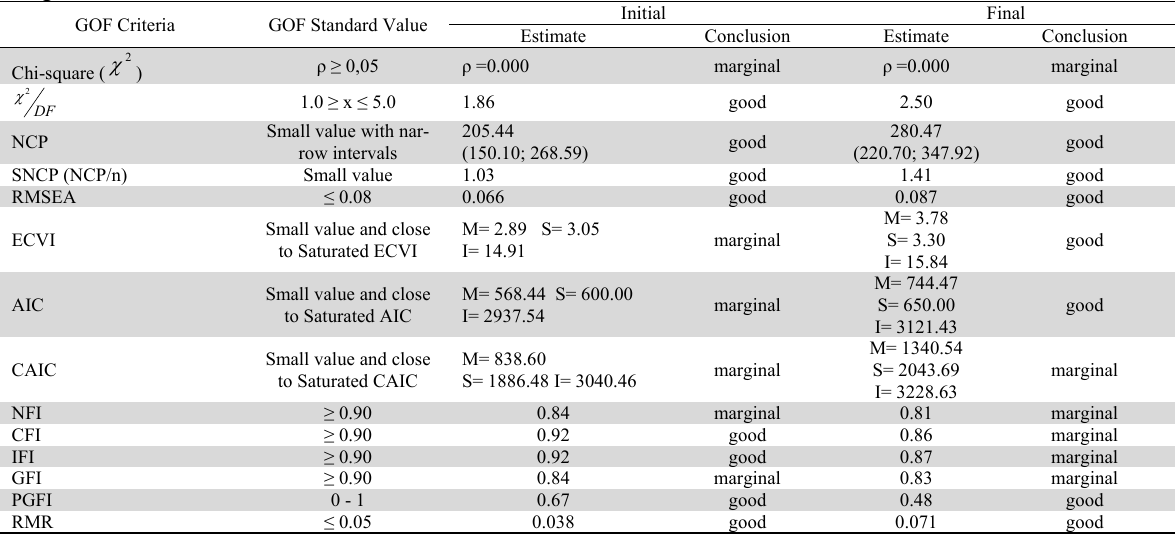
The goodness of fit model